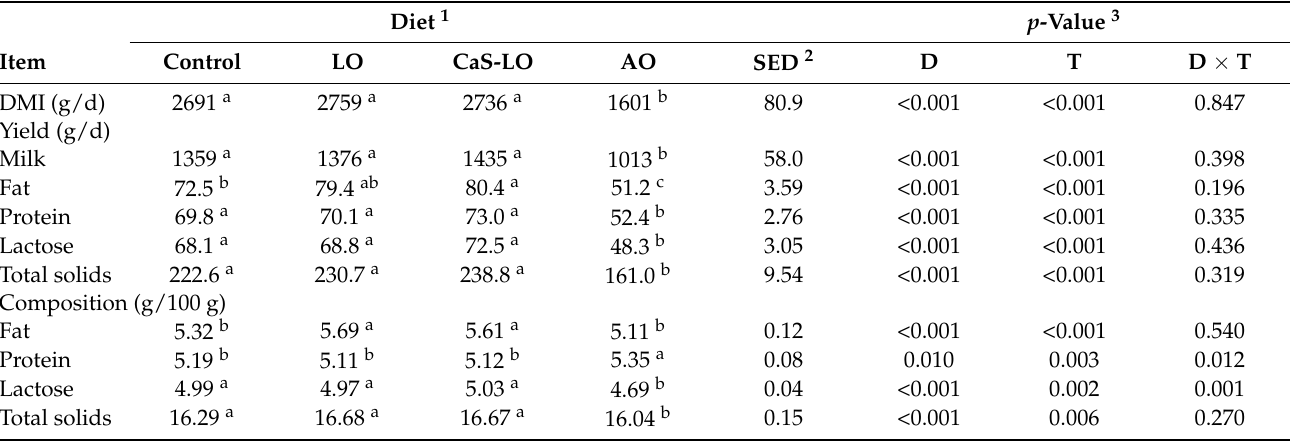
Table 2. Dry matter intake (DMI), and milk yield and composition in ewes fed a TMR containing 2.3% of different lipid